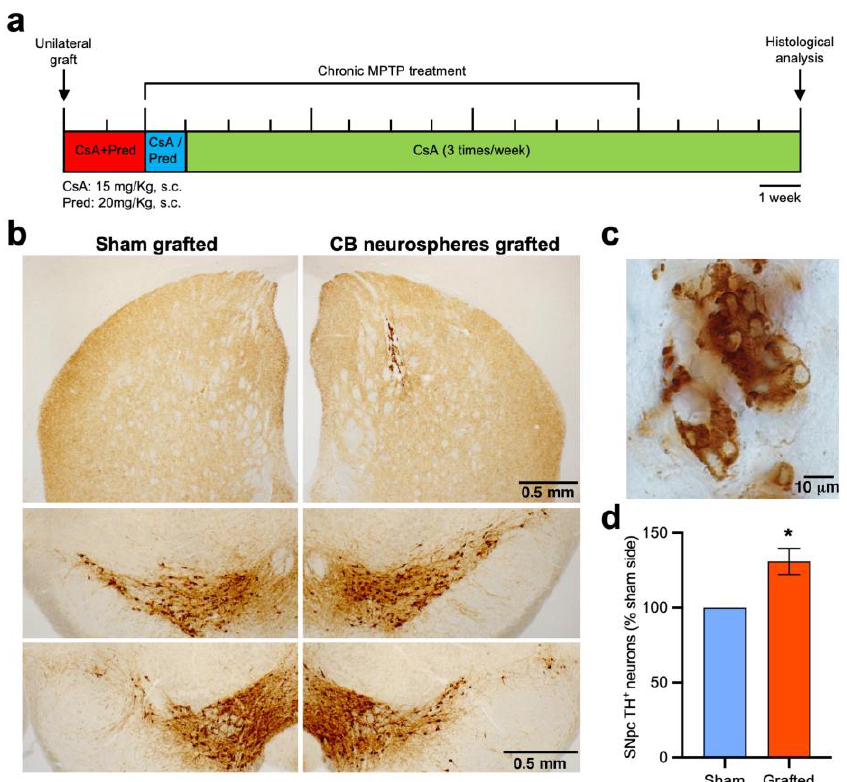
Figure 2. Protection of dopaminergic SNpc neurons through striatal xenografts of CB stem-cell-derived glomus cells. ( a ) Scheme of the experimental protocol used to analyze the neuroprotective effect of in vitro-expanded rat CB cells on mice dopaminergic nigrostriatal neurons. ( b ) Brain coronal sections, after TH immunohistochemistry, showing the sham (left panels) and CB-neurospheres-grafted (right panels) hemispheres at the level of striatum (top) and SNpc (middle and bottom). ( c ) Image, at higher magnification and after TH immunostaining, of the CB stem-cell-derived cells grafted in the striatum, showing an abundant number of in vitro-expanded dopaminergic glomus cells. ( d ) Stereological quantification, expressed as percentage of sham-grafted side, of ipsilateral TH + SNpc neurons to the grafted striatum. Paired Wilcoxon test; n = 5; * p < 0.05.